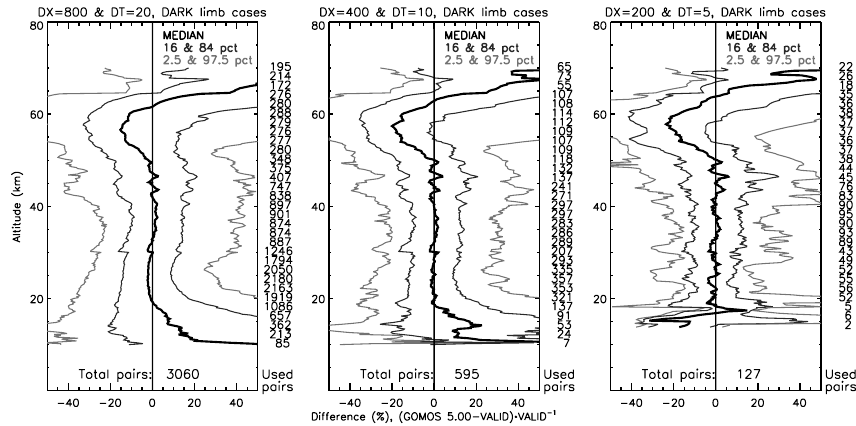
Fig. 9. As Fig. 4, here showing the effect of making the collocation criteria stricter. Left panel: cases with a maximum difference of 800km and 20h; middle panel: 400km and 10h maximum difference; right panel: cases fulfilling a 200km and 5h maximum Figure 9: As Figure 4, here showing the effect of making the collocation criteria stricter. Left 3 panel: cases with a maximum difference of 800 km and 20 hours; middle panel: 400 km and 4 10 hours maximum difference; right panel: cases fulfilling a 200 km and 5 hours maximum 5 difference. 6